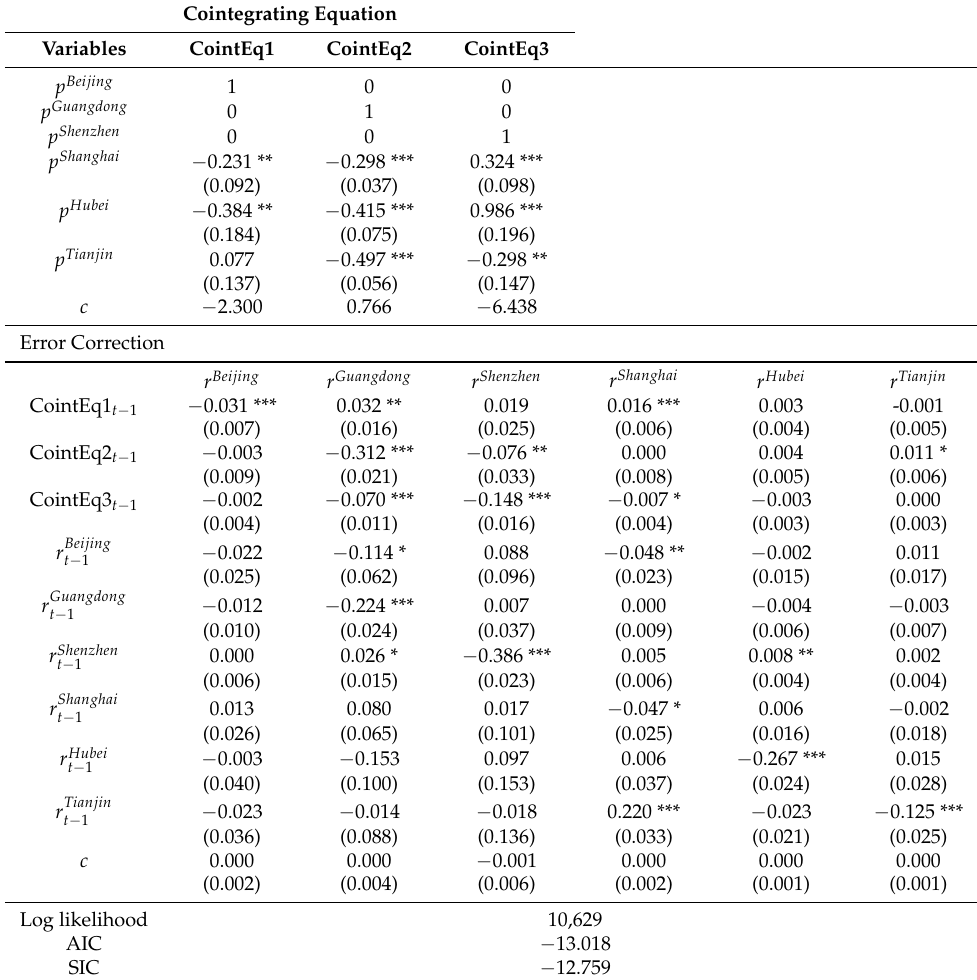
Table 5. VECM estimation result for the first